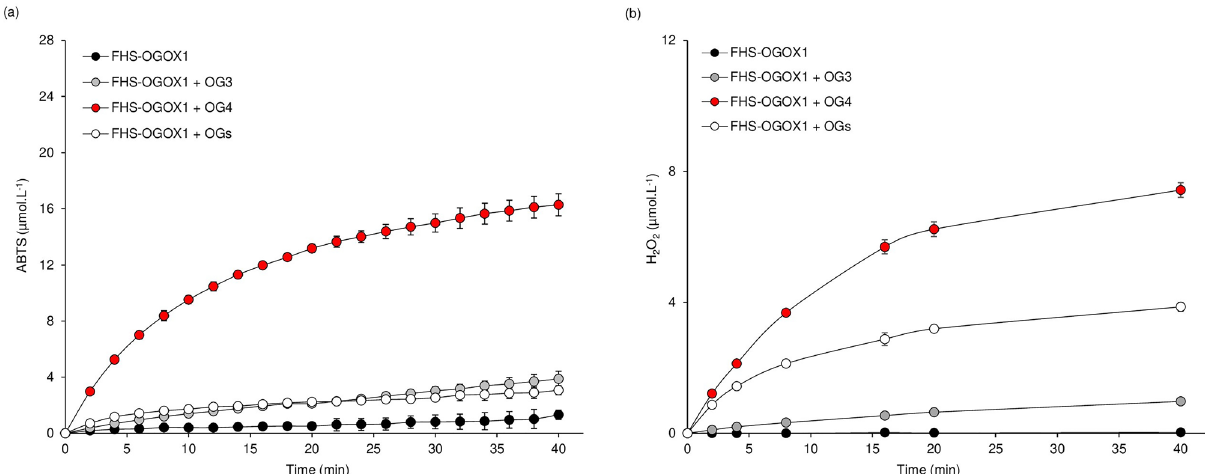
Figure 2. Scavenging activity of FHS-OGOX1 and short OG-oligomers towards the radical cation ABTS ·+ . ( a ) Production of ABTS (µmol.L −1 ) over time at pH 5.0 by the activity of FHS-OGOX1 (4 nM) using equimolar amounts (15 µM) of OG3, OG4 and OGs in the presence of ABTS ·+ -ABTS mixture (90–20 µM). ( b ) Production of H 2 O 2 (µmol.L −1 ) over time at pH 5.0 by the activity of FHS-OGOX1 (4 nM) using equimolar amounts (15 uM) of OG3, OG4 and OGs. Values are mean ± SD (N = 3). [ ABTS 2,2’-azino-bis (3-ethylbenzothiazoline-6- sulfonic acid), FHS-OGOX1 flag-his-sumoylated oligogalacturonide-oxidase 1, OGs oligogalacturonides, OG4 tetra-galacturonic acid, OG3 tri-galacturonic